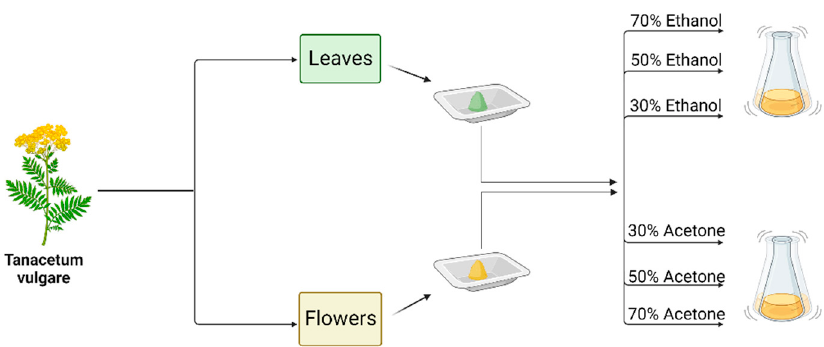
Figure 1. Plant material extraction process.